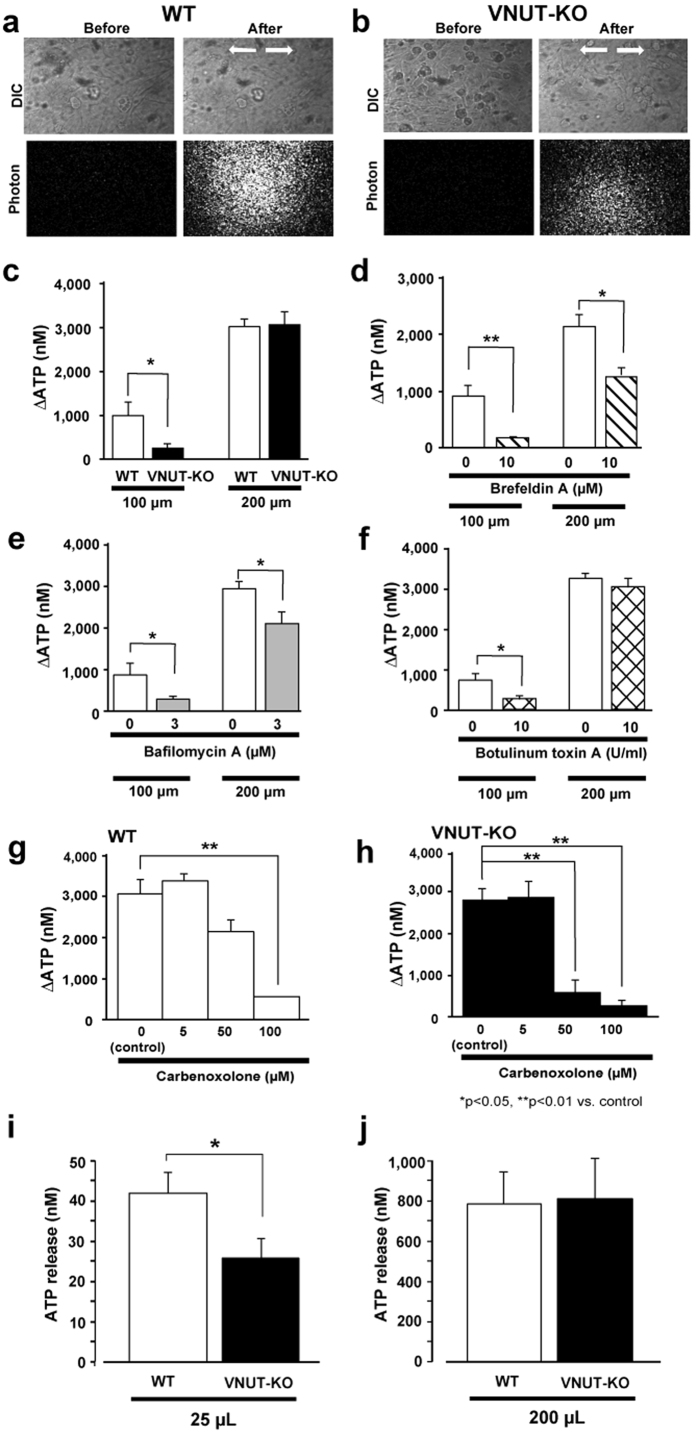
Visualization and characterization of stretch-evoked ATP release from primary urothelial cell cultures or the bladder in vivo.(a,b) The upper panels show urothelial cells in differential interference contrast images (DIC) for WT and VNUT-KO samples, and the lower panels show photon counting images (white dots) in the corresponding fields. The stretch speed was 100 μm/s, and the distance was 100 μm (10% elongation). Cells were stretched transversely (as indicated by the arrows). (c) The average amount of ATP released from urothelial cells in response to a 100 μm (10%) and a 200 μm (20%) stretch in WT (n = 10) and VNUT-KO cells (n = 8). Effects of (d) Brefeldin A (n = 4, control n = 4), (e) bafilomycin A (n = 8, control n = 8) and (f) botulinum toxin A (n = 6, control = 7) on ATP release with stretching (10% or 20%) in WT cells. The average amount of ATP released from urothelial cells that were obtained from WT (g) and VNUT-KO (h) mice in response to 200 μm of stretching (20% elongation). The effects of various concentrations of carbenoxolone (5–100 μM, n = 4–6 at each concentration) are shown. (i,j) The saline infusion-evoked ATP release from the mouse bladder in vivo. The bladder was washed with saline three times, and then after 30 min incubation either (i) 25 μl or (j) 200 μl of saline containing ARL 67165 (100 μM) was slowly injected into the bladder of WT (n = 15) or VNUT-KO (n = 8) mice using PE10 tubes. The saline was collected and the ATP concentration measured. Data are mean ± SEM. Asterisks indicate a significant difference compared with the responses of VNUT-KO or control cells (*P < 0.05, **P < 0.01; Student’s t-test).